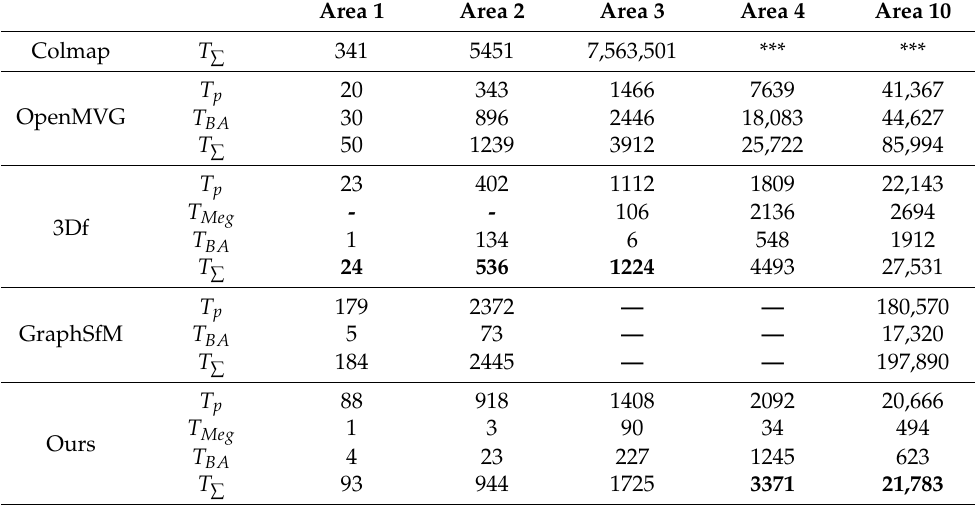
Table 8. Oblique photography dataset efficiency statistics. ( T p : local reconstruction time; T Meg : subcluster merging time; T BA : global bundle adjustment time; T ∑ : total time. - represents no merging operation, such as with 3Df where scene partitioning is not performed with less than 1000 images, and time is no longer counted; — represents failure, time unit: seconds; *** represents the reconstruction time is more than fifteen